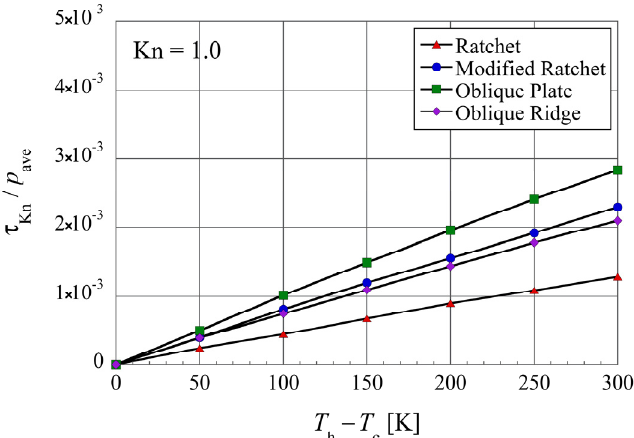
Figure 12. Net tangential Knudsen stresses, i.e., propulsive forces per unit area, for different surface microstructures at different temperature differences, in the case of Kn = 1 and ( T h + T c ) /2 = 400 K .